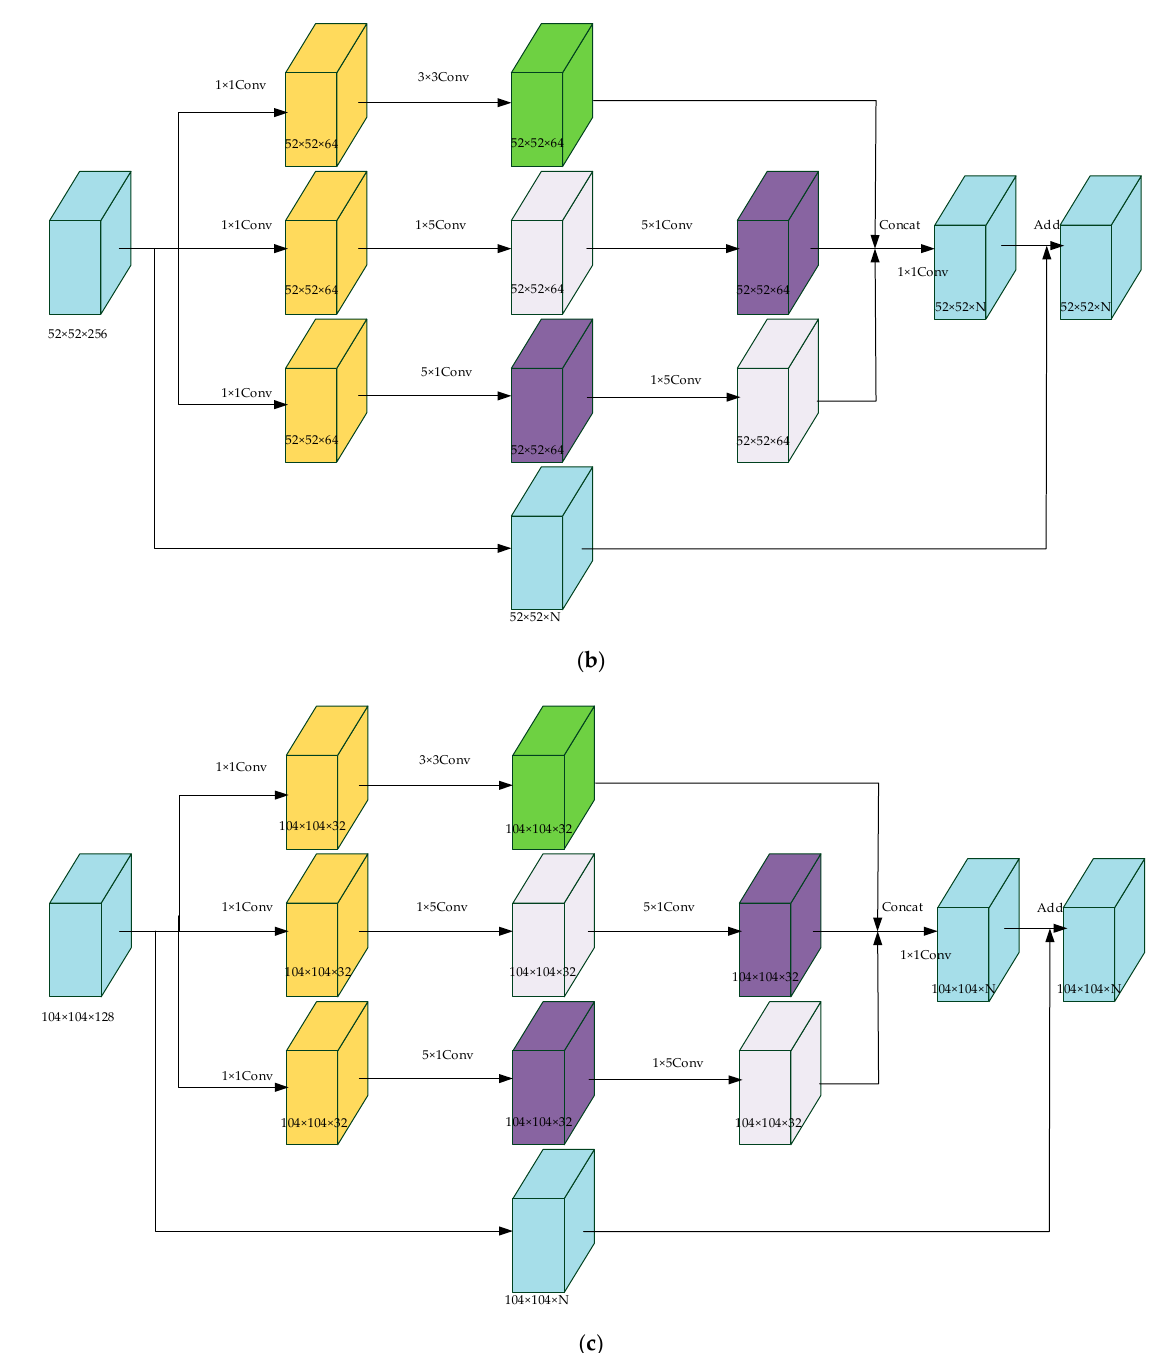
Figure 9. The structures of ResNet Feature Enhancement Modules (IRFE). ( a ) IRFE1 for Scale 1. ( b ) IRFE2 for Scale 2. ( c ) IRFE3 for Scale 3.